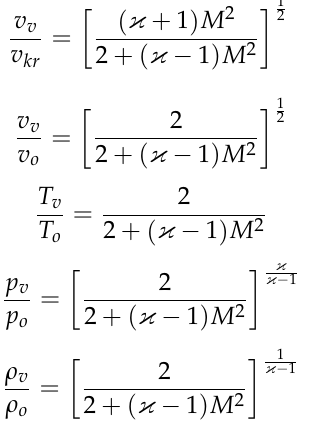
Figure 8. Laval nozzle—Linear shape. Reprinted from ref. [26].